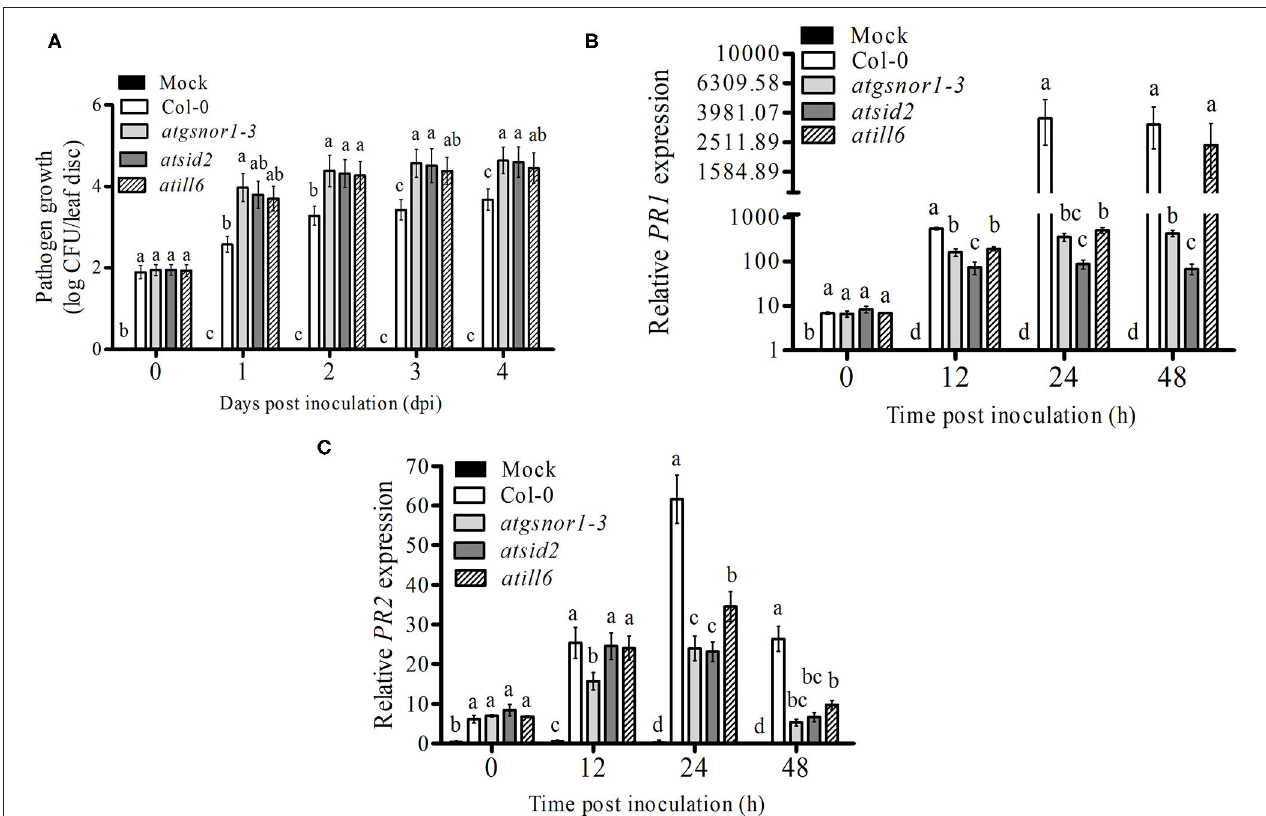
FIGURE 2 | ATILL6 positively regulates the plant basal defense. (A) pathogen growth and (B,C) Relative gene expressions of PR1 and PR2 genes from infiltrated leaves in the indicated genotypes after inoculation with Pst DC3000 virulent bacteria. All data points are the means of three replicates, and error bars represent ± standard error. The significant difference between the treatments is represented by (a, b, c, d), one-way ANOVA analysis of varience, followed by Duncan’s multiple range test using statistical analysis system (SAS